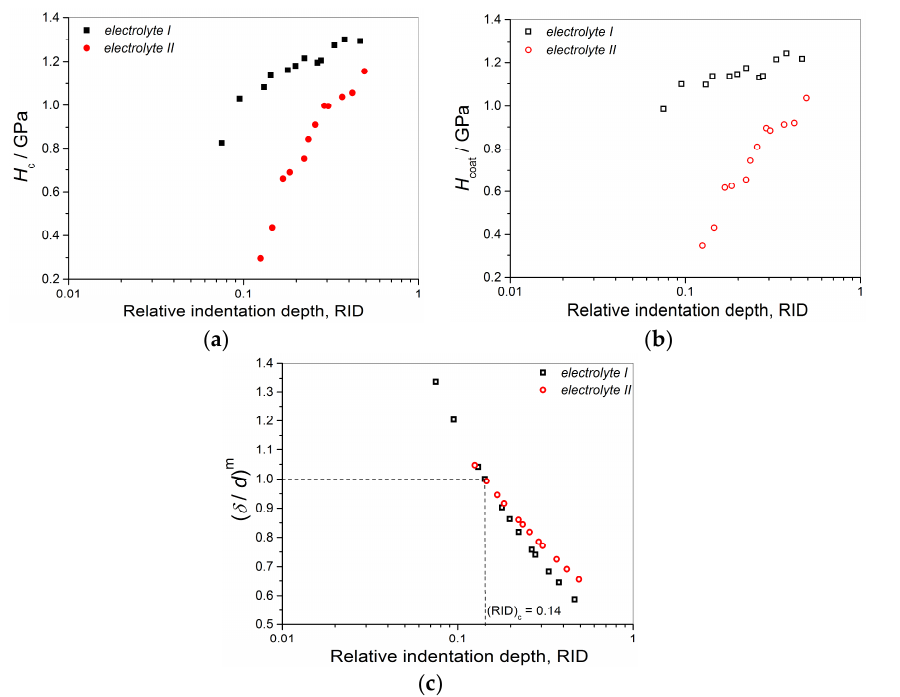
Figure 4. The dependencies of ( a ) the composite ( H c ) and ( b ) the calculated coating ( H coat ) hardness on the RID for the 20 µm thick Cu coatings electrodeposited on the brass from electrolytes I and II , and ( c ) the dependencies of ( δ / d ) m on the RID for the same Cu